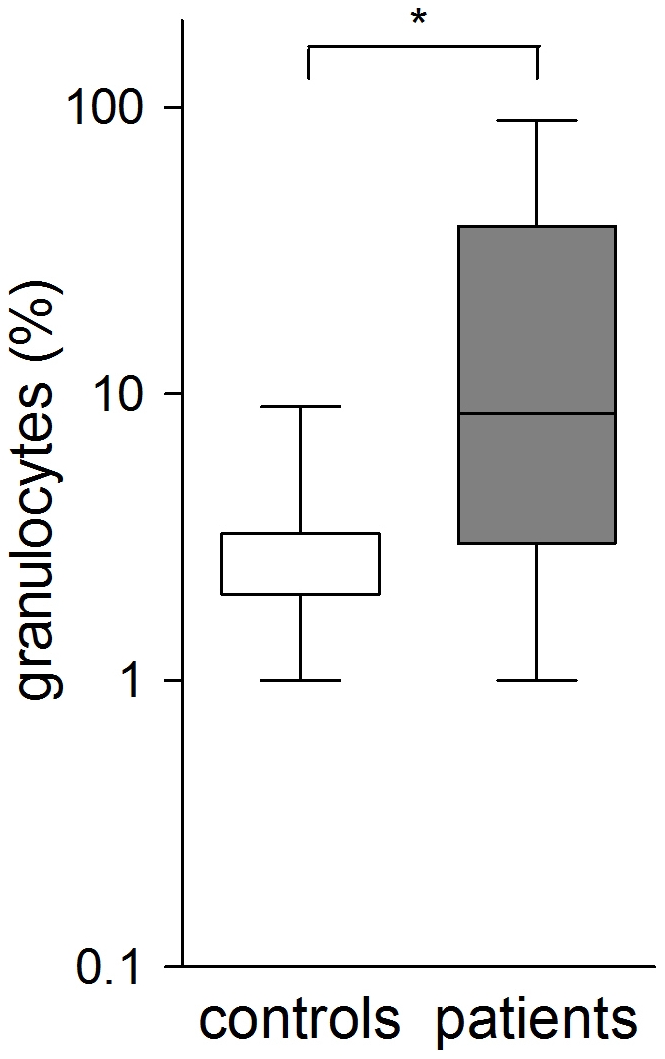
Comparison of granulocyte and bacterial count in the bronchoalveolar lavage fluid of patients, number of patients: n = 42, significance levels were calculated using Mann- Whitney- U- Test (p<0,005).